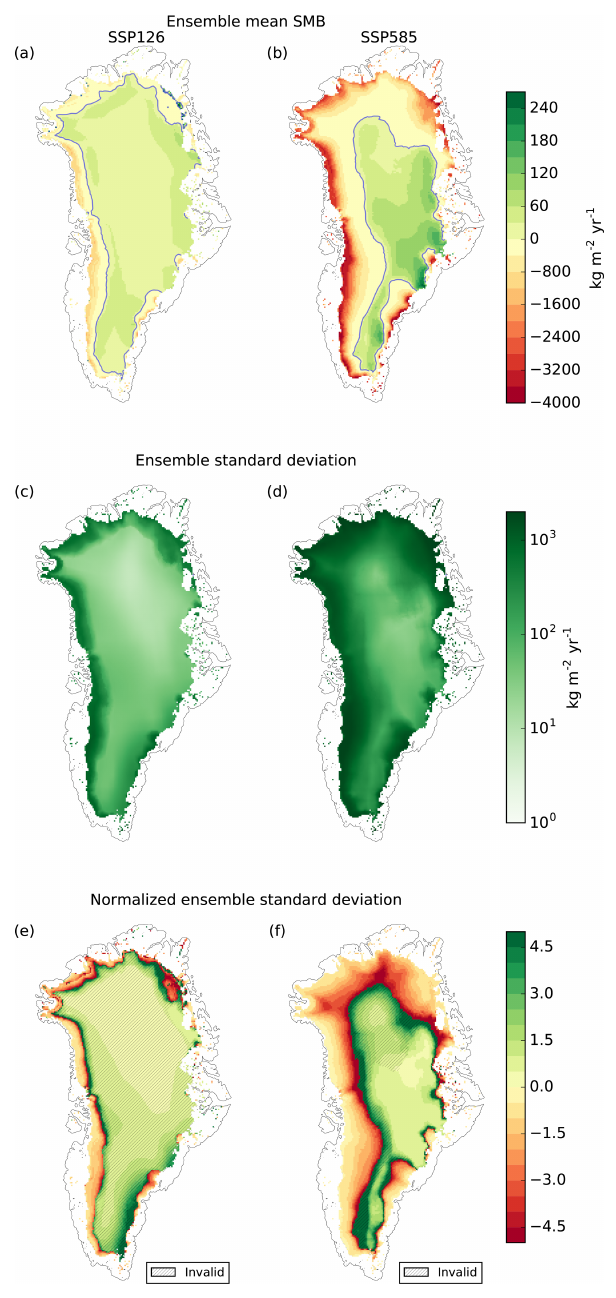
Figure 3. Anomaly of the median SMB over all parameter combina- tions (2090–2099 mean) with respect to ERA-Interim (1979–2014 mean) (a, b) with standard deviation (c, d) and relative standard de- viation (e, f) for the scenarios SSP126 (a, c, e) and SSP585 (b, d, f) . (a, b) The contour line indicates a mass balance of zero. Note the different scales for positive and negative values. (e, f) In the shaded area, the absolute value of the surface mass balance is smaller than 50kgm − 2 , which is considered to be close to zero, and thus the relative standard deviations are invalid.